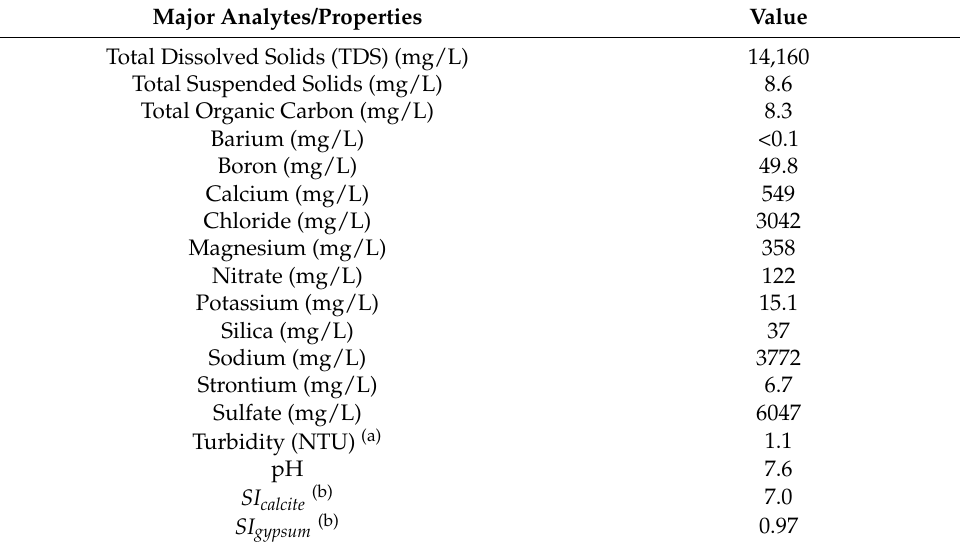
Table 1. Agricultural brackish feedwater